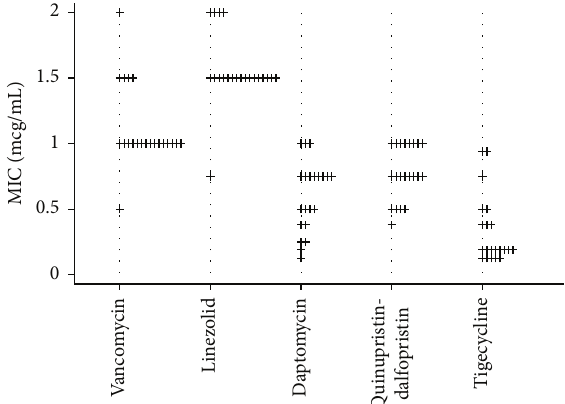
Figure 1: Distribution of specific antibiotic minimum inhibitory concentrations (MICs) by Etest for MRSA blood